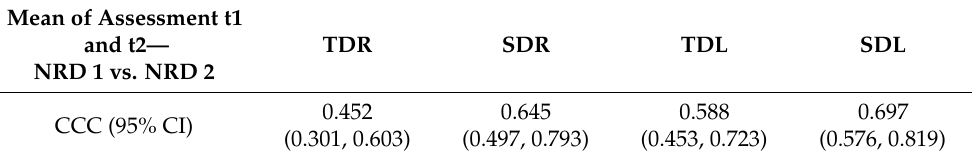
Table 6. Inter-rater agreement in ONSD MRI assessment between the mean of the two assessments for the two NRDs (mean of assessments t1 and t2, NRD 1 vs. NRD 2). Inter-rater agreement in MRI comparing the mean values of assessments I and II between the two